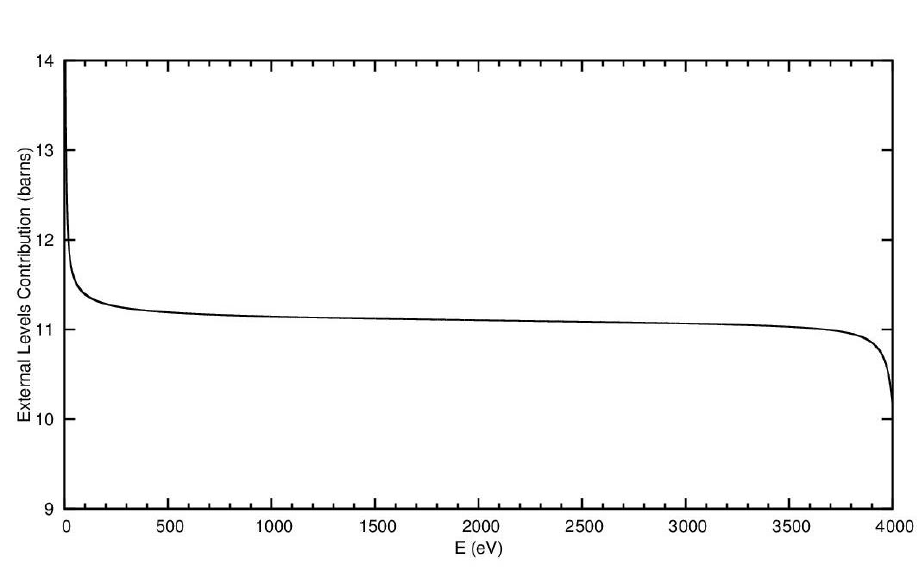
Figure. 1. External levels contribution on the scattering cross-section in the energy ranges 10 -5 eV to 4